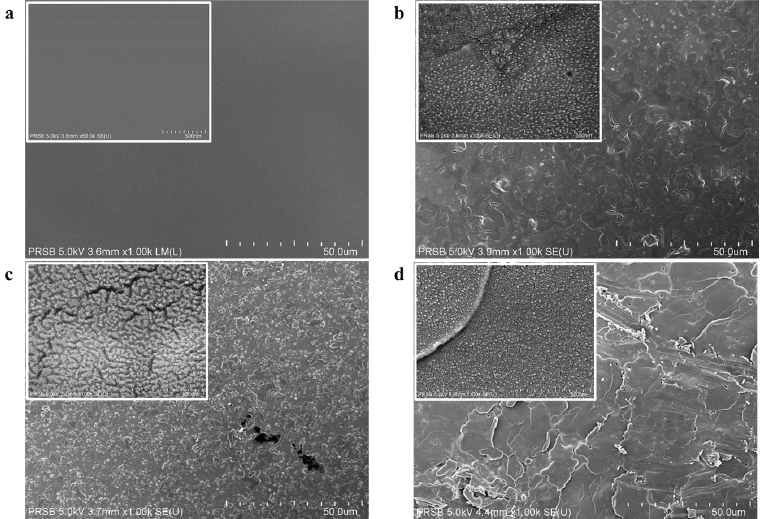
Figure 7. SEM micrographs of the surface of ( a ) neat CMC film, ( b ) 0.25 wt% lignin/CMC film, ( c ) 0.5 wt% lignin/CMC film, and ( d ) 1 wt% lignin/CMC film. Regular images were taken at 1000 × magnification, and the insert images were at 60,000 ×